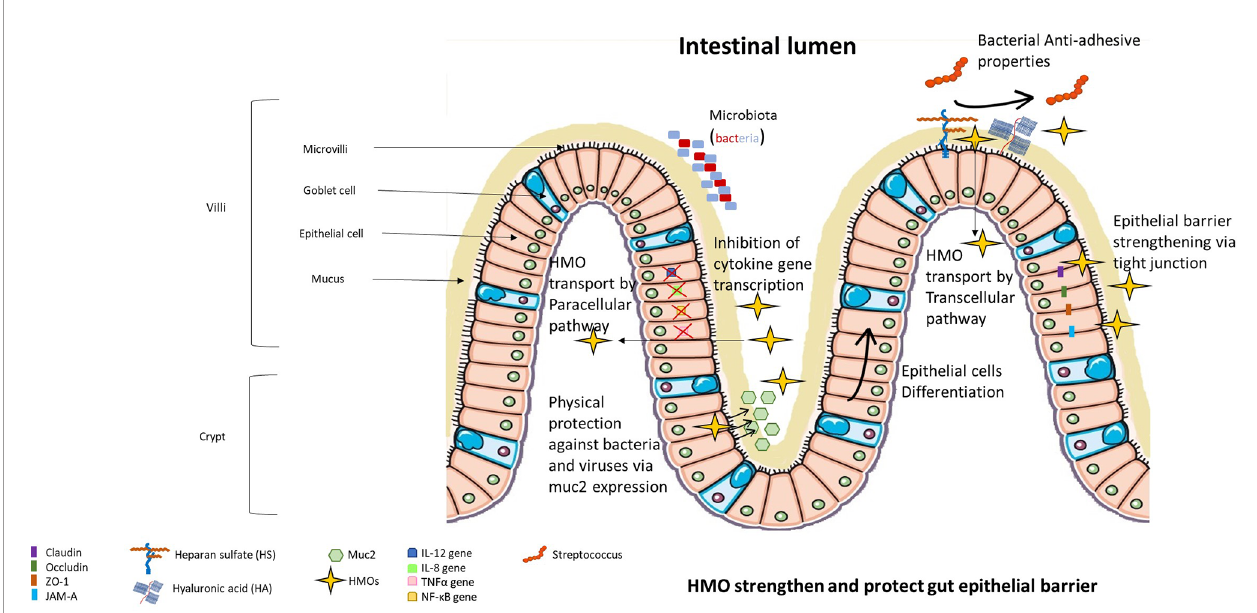
FIGURE 3 | HMOs strengthen and protect the gut epithelial barrier. HMOs are able to modify the extracellular glycocalyx of epithelial cells, limiting the adhesion of bacteria and viruses to epithelial cells. HMOs can protect the intestine due to their capacity to amplify the secretion of muc2 (main protein constituting the mucus protecting epithelial cells) and their capacity to strengthen tight junctions. A small portion of HMOs can be absorbed and thus can modulate gene expression inside epithelial cells, limiting their proliferation and inducing their differentiation into villus enterocyte-type cells. Absorbed HMOs also limit the expression of proin fl ammatory